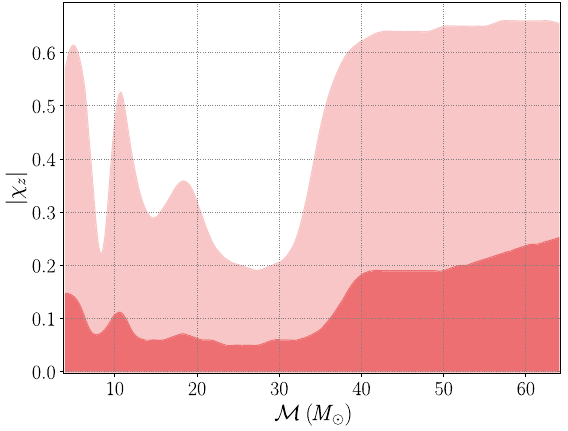
FIG. 19. The dependence of aligned-spin magnitude on the chirp mass. The light (dark) shaded regions are the aligned-spin magnitude at a credibility 90% (50%). The distribution is consistent with small values for lower chirp-mass binaries; however, the spin magnitude is less tightly constrained for chirp masses of 30 M ⊙ and